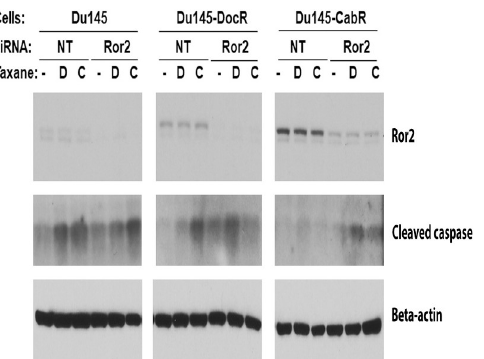
Fig 7. Ror2 knock-down resensitizes Du145-CabR cells to taxanes. Expression levels of Ror2 protein in association with cleaved caspase-3 in Du145 age-matched and taxane resistant cell lines transfected with non-targeting (NT) or Ror2-specific siRNA, and subsequently treated with Doc (D), Cab (C) or placebo. Beta-actin was used to verify protein equal loading.